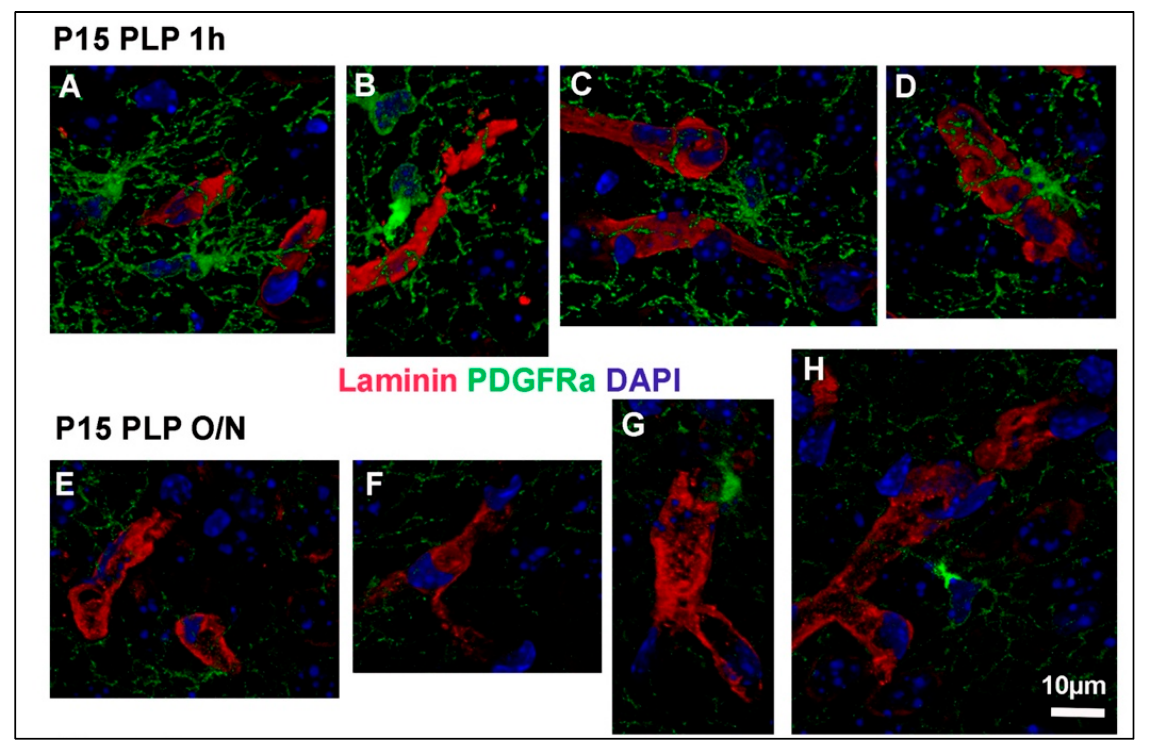
Figure 5. OPC protrusions contacting blood vessels. Three-dimensional reconstructions of OPCs contacting blood vessels are shown for P15 PLP 1 h ( A – D ) and P15 PLP O/N ( E – H ). Laminin-positive vessels are shown in red, PDGFR α -positive OPCs are shown in green, DAPI staining is shown in blue. Note that contacts are clearly visible in the short fixation protocol but hard to detect in the long fixation protocol. Regions of interest were taken from 40 z-stacks reconstructed with the Leica LAS X software for 3D reconstruction. Scale bar represents 10 µm.